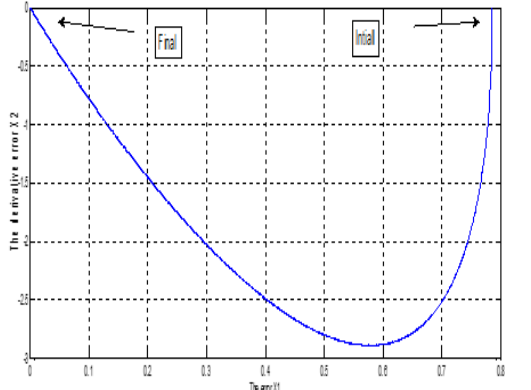
Fig. 17. The error d vs. time of the ISMC. vs. time of the ISMC. ‘